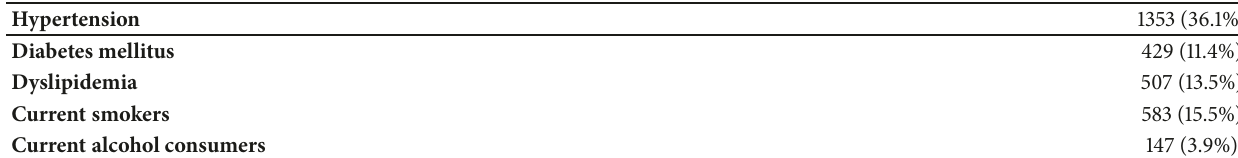
Table 4: Risk factors of